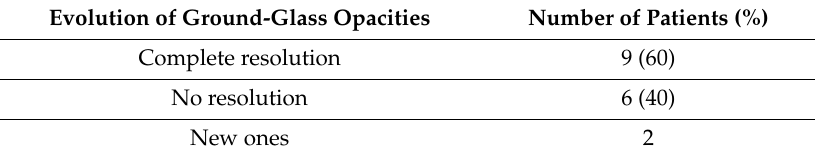
Table 6. Evolution of the 15 patients who presented ground-glassopacities.